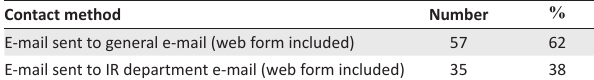
TABLE 2: Summary of contact method